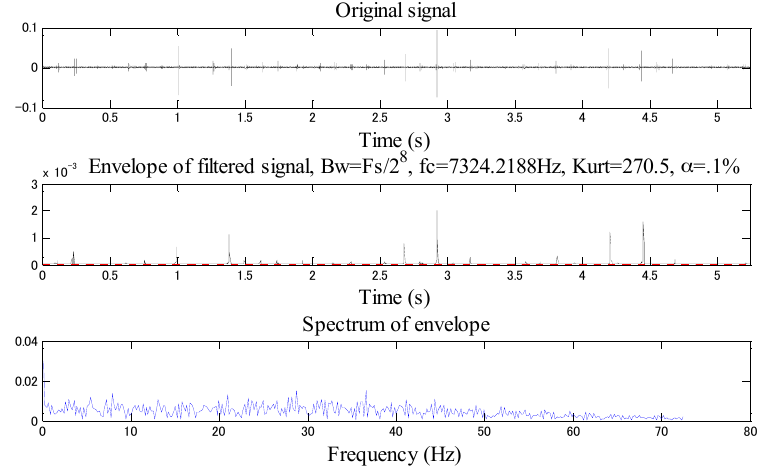
Figure 28. Time domain waveform, envelope, envelope spectrum of the Fast Kurtogram filtered signal.